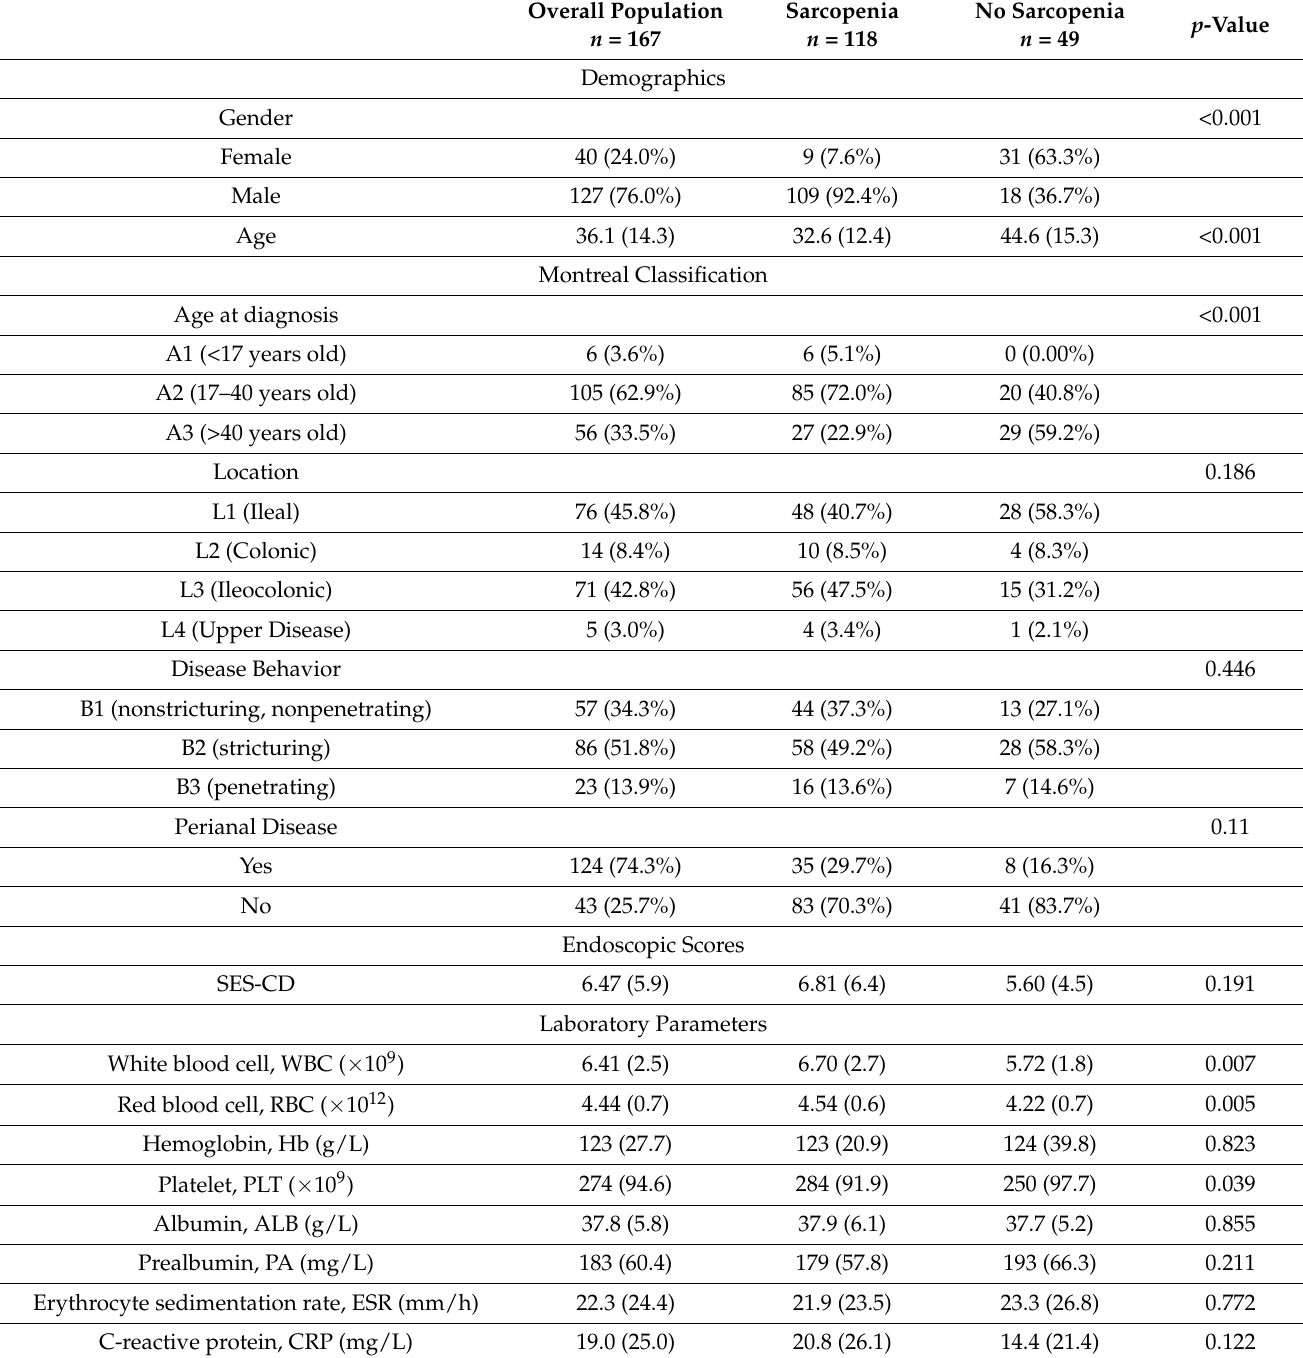
Table 1. Baseline clinical, anthropometric, and radiological characteristics of the included